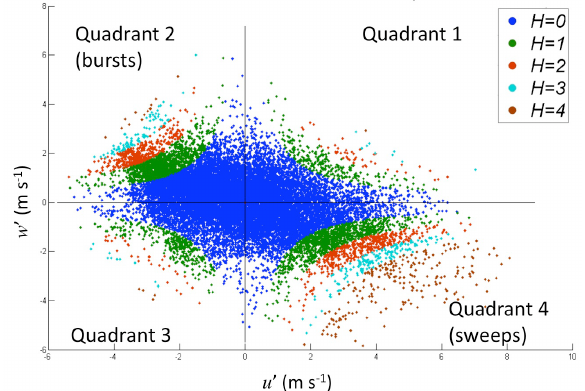
Figure 2. Sample 30-­‐minute analysis (28 July 2009 (DOY 209), 12:30 – 13:00LT) using the quadrant analysis method for different hole sizes. Each point represents a 10Hz sonic data point. Note as the hole size increases weak events are excluded, thus for large hole sizes (H=4) only extreme events are considered.